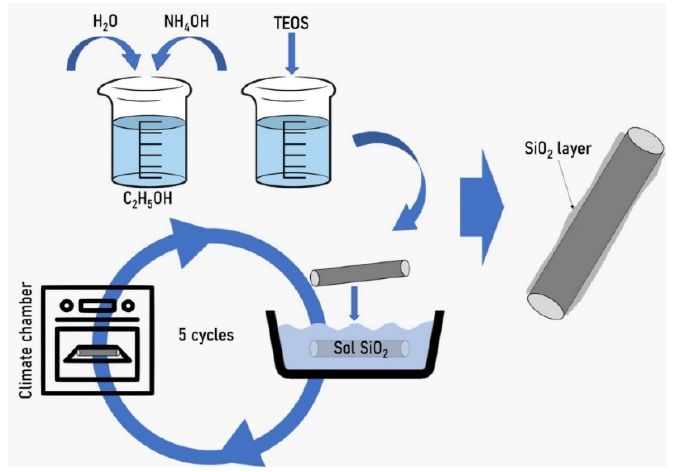
Figure 1. Scheme of formation of a nanostructured coating by SiO 2 sol deposition.